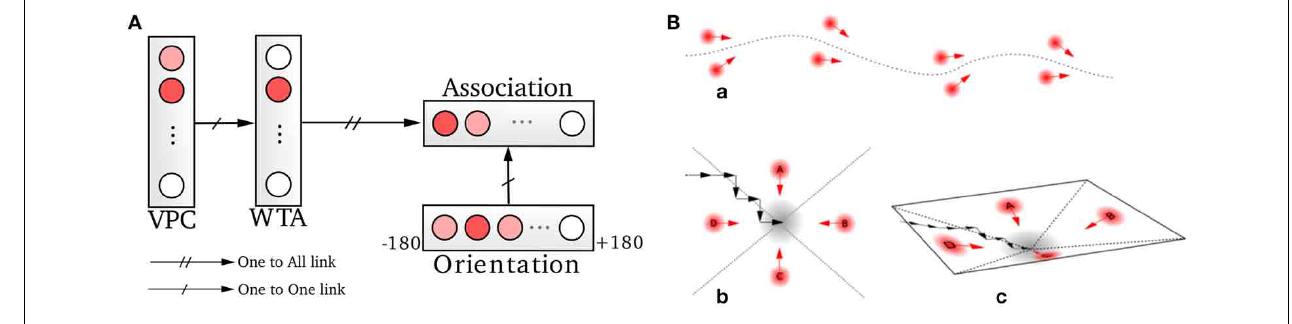
FIGURE 6 | Homing mechanism based on a simple sensory-motor loop relying on vision. (A) A particular action (a direction in our case) is associated with each winning visual place cell (VPC). This association is learned by a least mean square algorithm. The system is then able to move in the learned